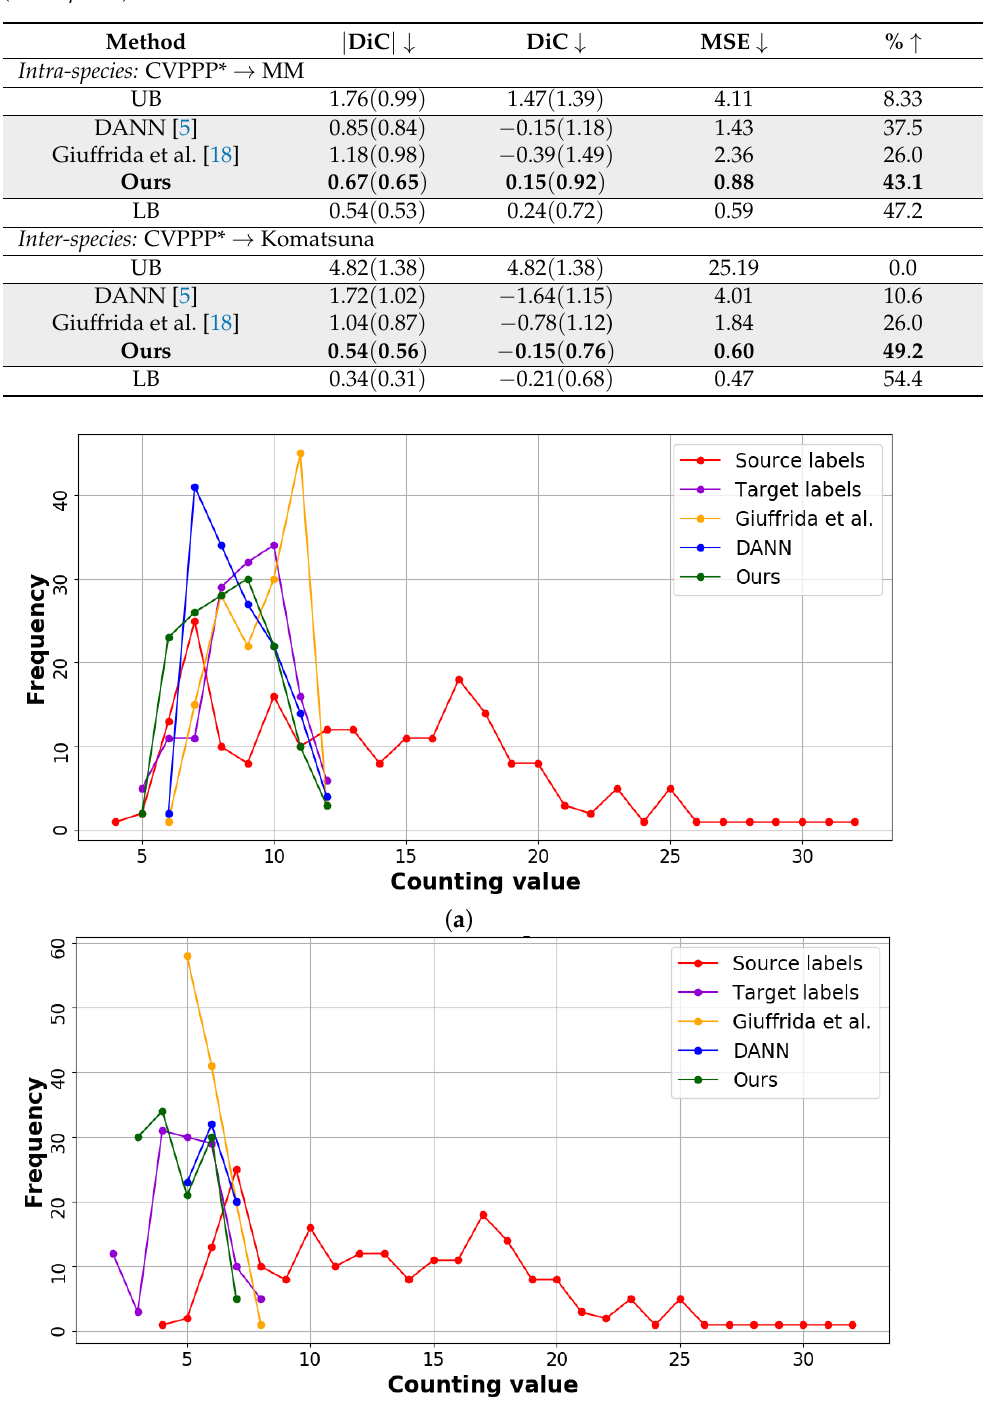
Table 4. Leaf counting DA results for the CVPPP* → MM ( intra-species ), and CVPPP* → Komatsuna ( inter-species ) scenarios.